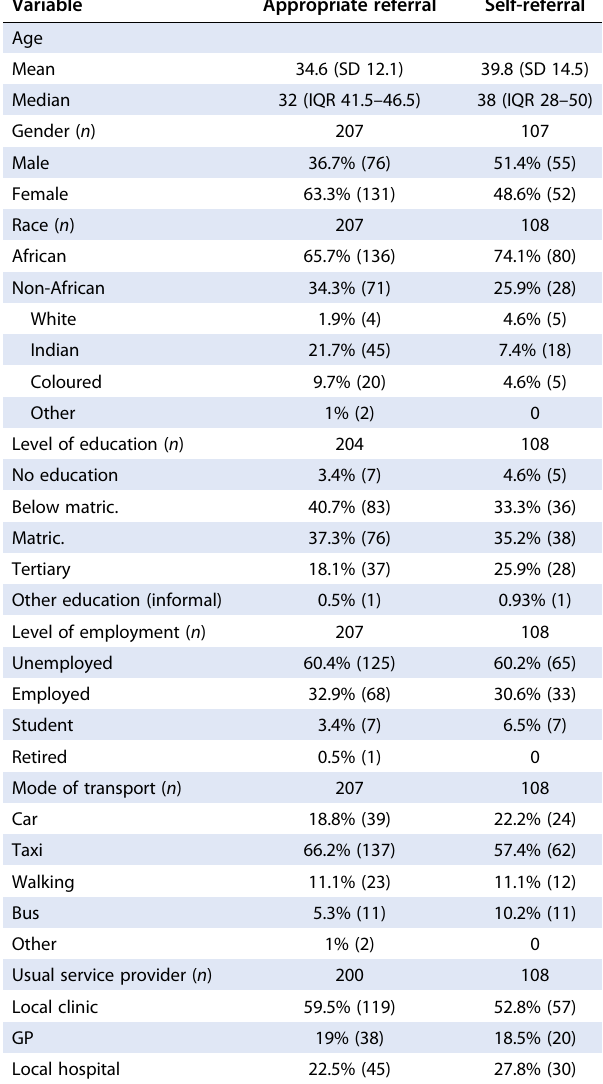
Table 2: Frequency table of the sociodemographic profile between referred and self-referred participants at district and district/regional hospitals in eThekwini between May and June 2015 ( n =